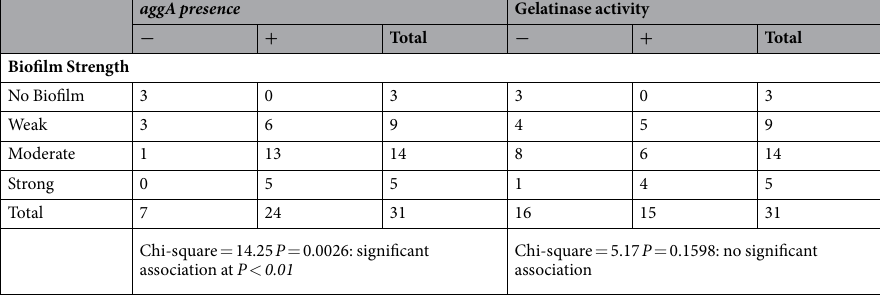
Table 4. Genotype–phenotype associations of agg PCR results and gelatinase activity with biofilm formation strength. + , positive; − , negative.